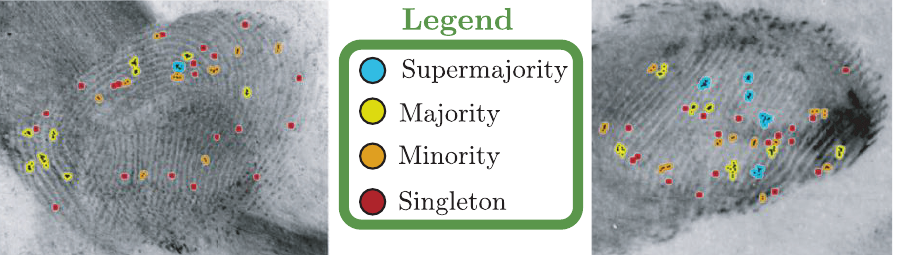
Figure 3. Two examples of latent fingerprints marked by several examiners, taken from [28]. Marked minutiae are shown as small black dots inside color-coded clusters. Singleton (marked by only one examiner), minority ( < 50% of examiners), majority (50–90%), and supermajority ( ≥